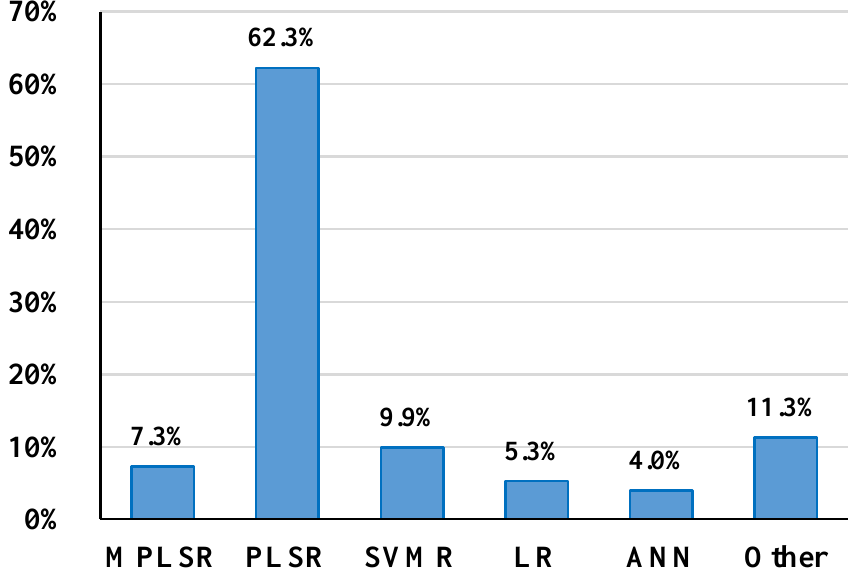
Figure 6. Machine learning and statistical methods employed as the regression tool in the reviewed studies (MPLSR: Modified Partial Least Square Regression, PLSR: Partial Least Square Regression, SVMR: Support Vector Machine Regression, LR: Linear Regression, ANN: Artificial Neural Network) .